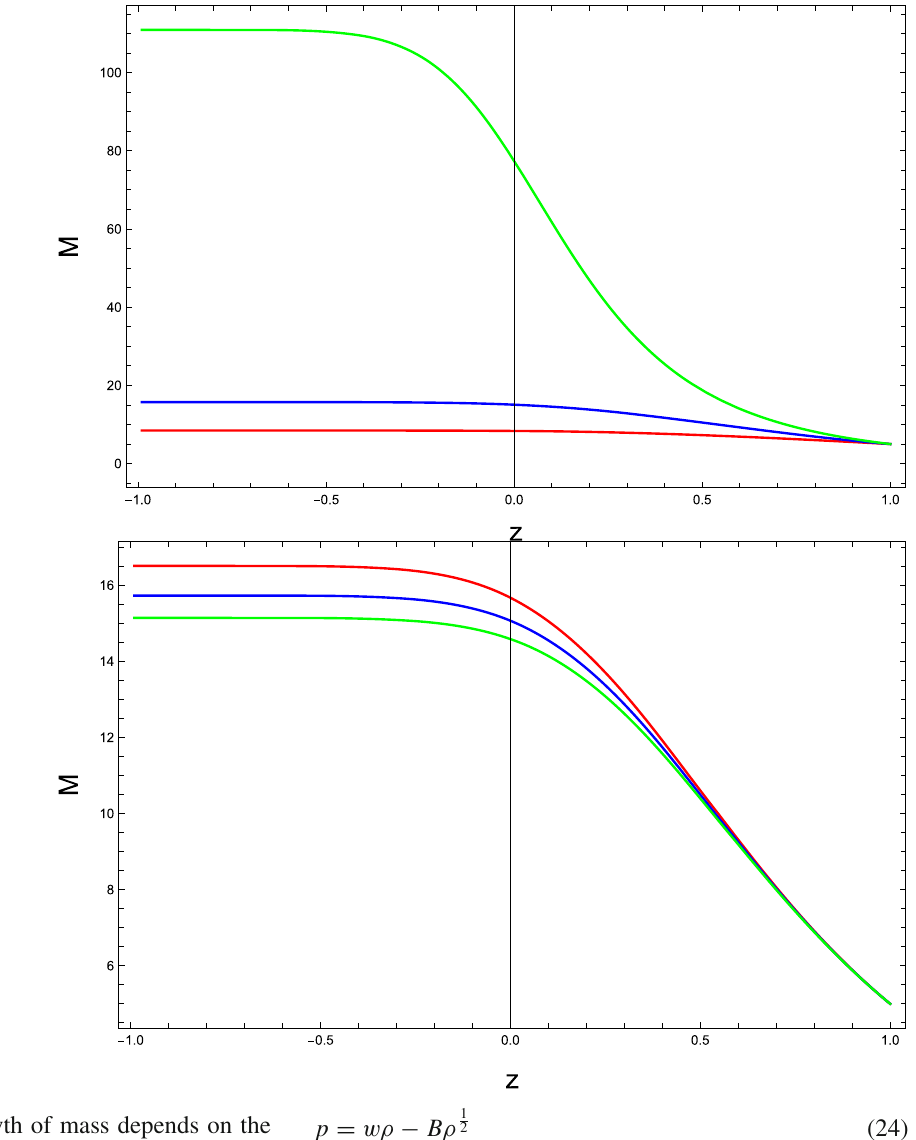
Fig. 3 Evolution of PBH mass M ( z ) vs. redshift z for different A and λ = 0 . 00007. With A = 0 . 3 (red), A = 0 . 5 (blue)